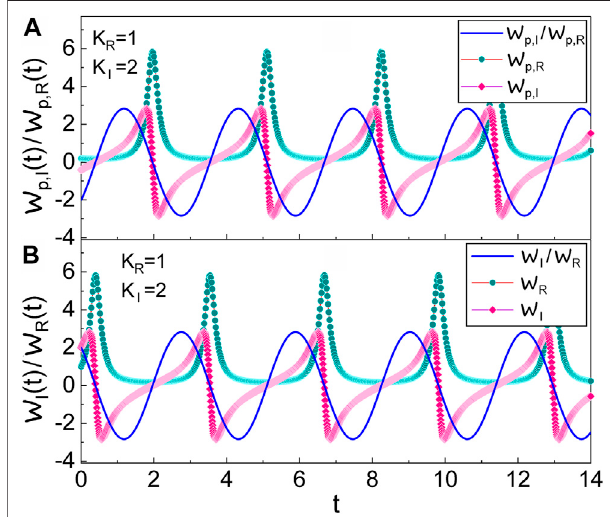
FIGURE 5 | (A) is the evolution of W p , I / W p , R with the components W p , R and W p , I , where K R (cid:1) 1 and K I (cid:1) 2. (B) is the evolution of W I / W R and its relevant components (comparison purpose). The values that we have used are A (cid:1) 1, B (cid:1) 5, C (cid:1) 2, ω (cid:1) 1, Z (cid:1) 1, ϵ (cid:1) 1, t 0 (cid:1) 0, and φ (cid:1)